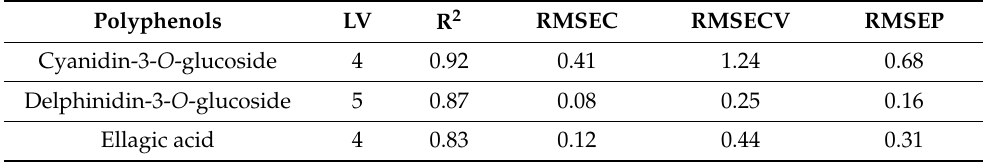
Table 2. Calibration parameters of models for predicting polyphenols in JPF.